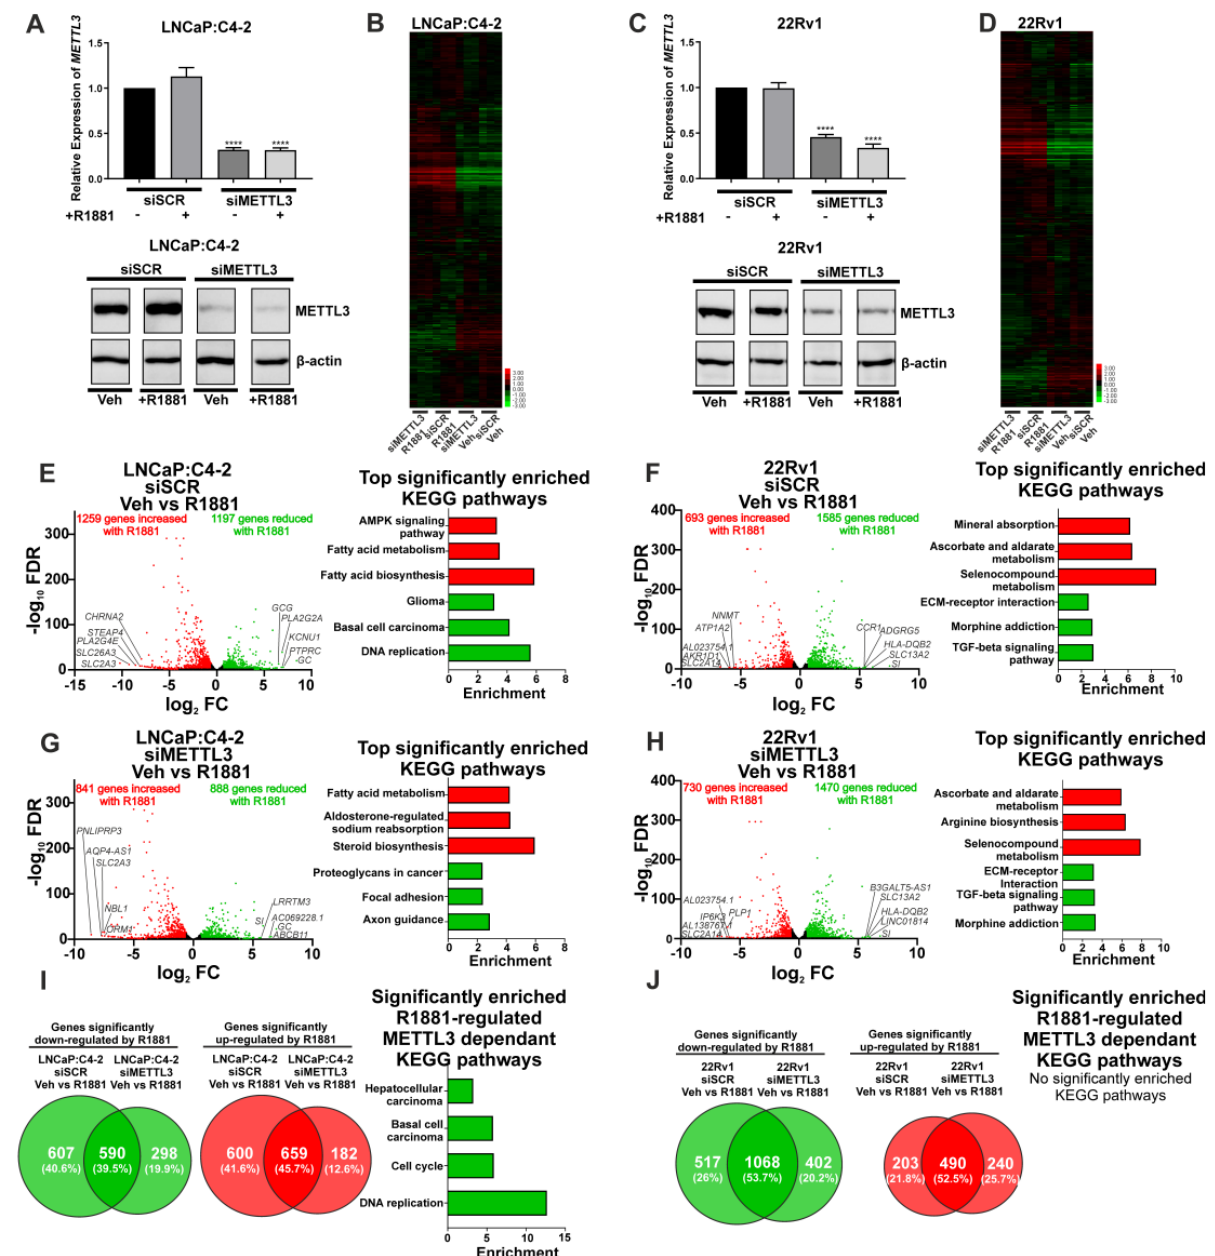
Figure 4. Knockdown of METTL3 influences androgen-induced transcriptional programmes in PCa cell lines. PCa cells treated with − /+ 1nM R1881 and − /+ si METTL3 were analysed by RNA-seq and the DEGs determined. METTL3 knockdown in LNCaP:C4-2 ( A ) and 22Rv1 ( C ) − /+ R1881 was confirmed by qRT-PCR and Western blotting. Heatmap of AR-regulated genes LNCaP:C4-2 ( B ) and 22Rv1 ( D ) siSCR and siMETTL3 treated with Veh or R1881. The androgen-induced differential gene expression and top significantly enriched KEGG pathways in siSCR Veh vs. R1881 and siMETTL3 Veh vs. R1881 in LNCaP:C4-2 ( E , G ) and 22Rv1 ( F , H ) is shown. Genes with significantly higher expression with R1881 treatment are indicated in red and genes significantly lower with R1881 treatment are indicated in green. Non-significantly DEGs are plotted in black. Common and uniquely regulated genes in siSCR vs. siMETTL3 and enriched KEGG pathways with METTL3 dependant R1881 regulated genes in LNCaP:C4-2 ( I ) and 22Rv1 ( J ) are shown. Significant gene expression: FC ± 1.5 and FDR < 0.05. **** p ≤ 0.0001. Molecular weights for proteins are indicated in the full uncropped annotated Western blot images (Figures S8 and